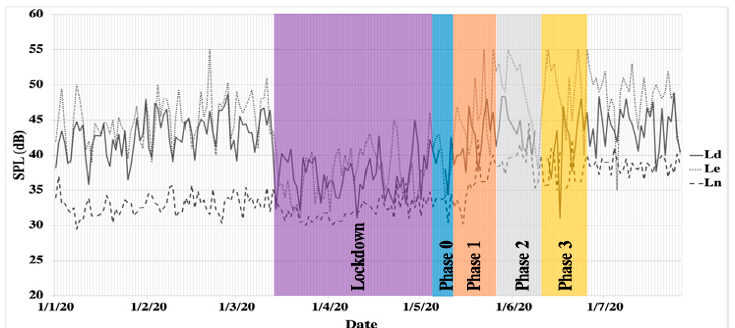
Figure 3. Long-term Sound Pressure Level (SPL) registered by Interlight S.L. L d : SPL for day pe- riod; L e : SPL for evening period; L n : SPL for night